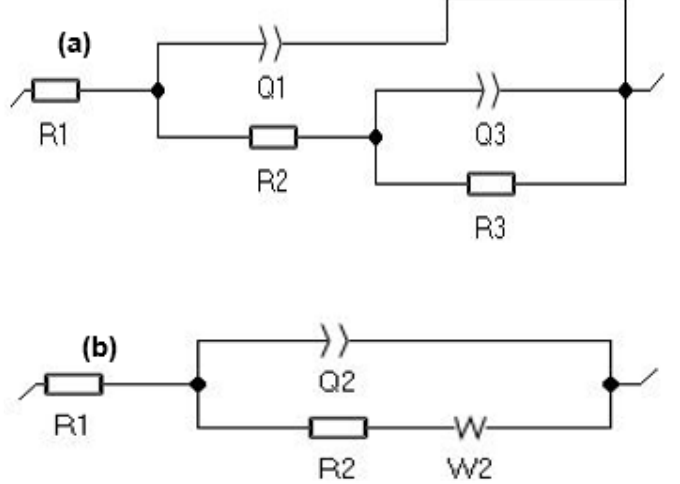
Figure 7. Randles equivalent circuit models corresponding to ( a ) WO 3 and Mn-WO 3 , and ( b ) SnS 2 , WO 3 / SnS 2 and Mn-WO 3 / SnS WO 3 /SnS 2 and Mn-WO 3 /SnS 2.